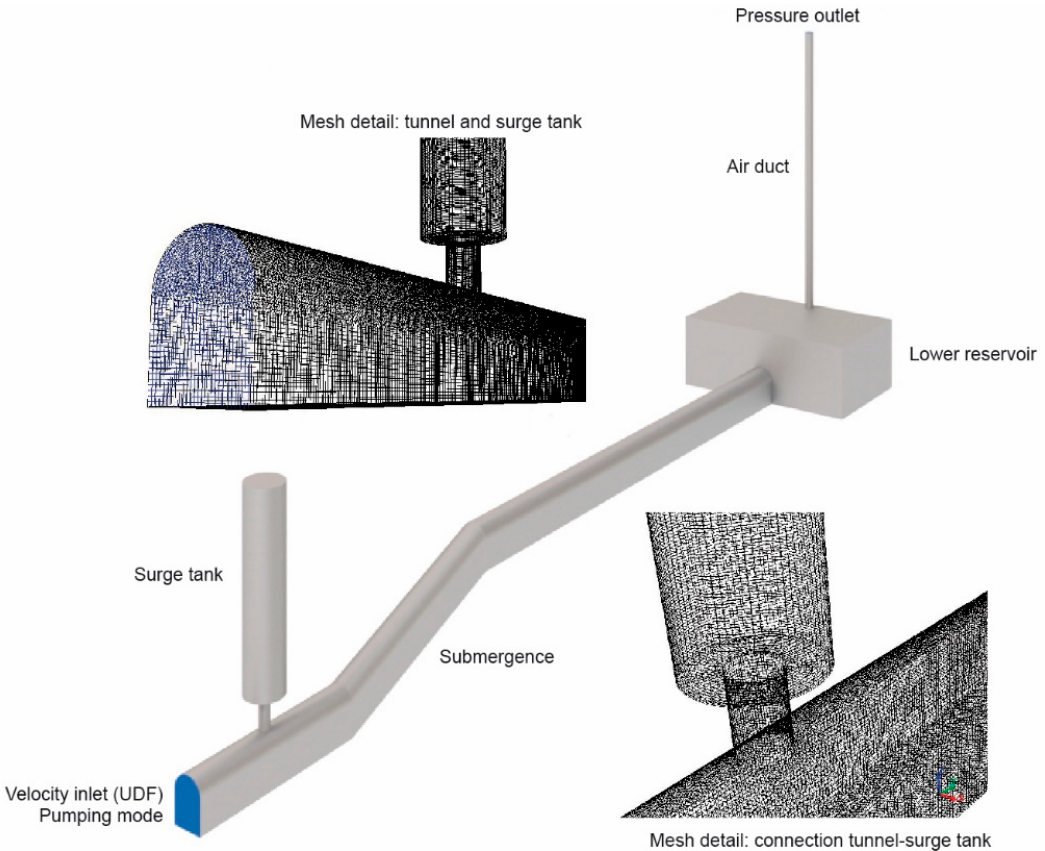
Figure 2. Three-dimensional computational domain, mesh details for the UPSH model and Figure 2. boundary conditions.